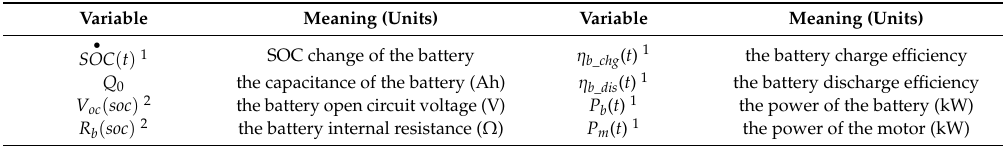
Table 4. Battery model variables.